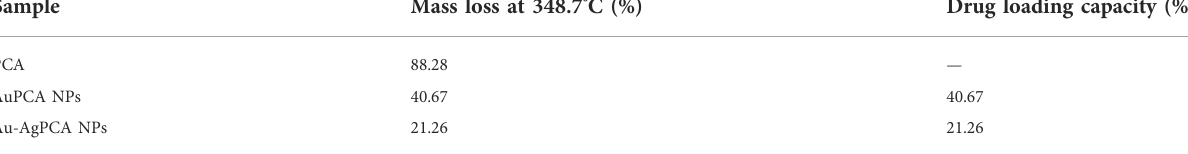
TABLE 1 Mass loss and drug loading capacity of PCA, AuPCA and Au-AgPCA.